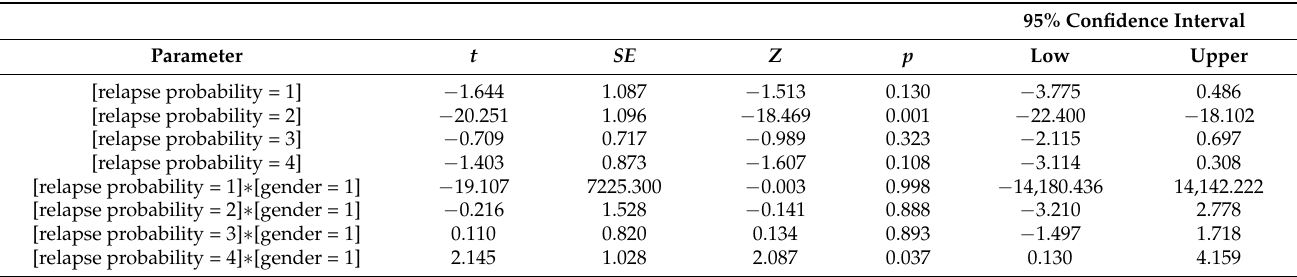
Table 10. The results of loglinear model